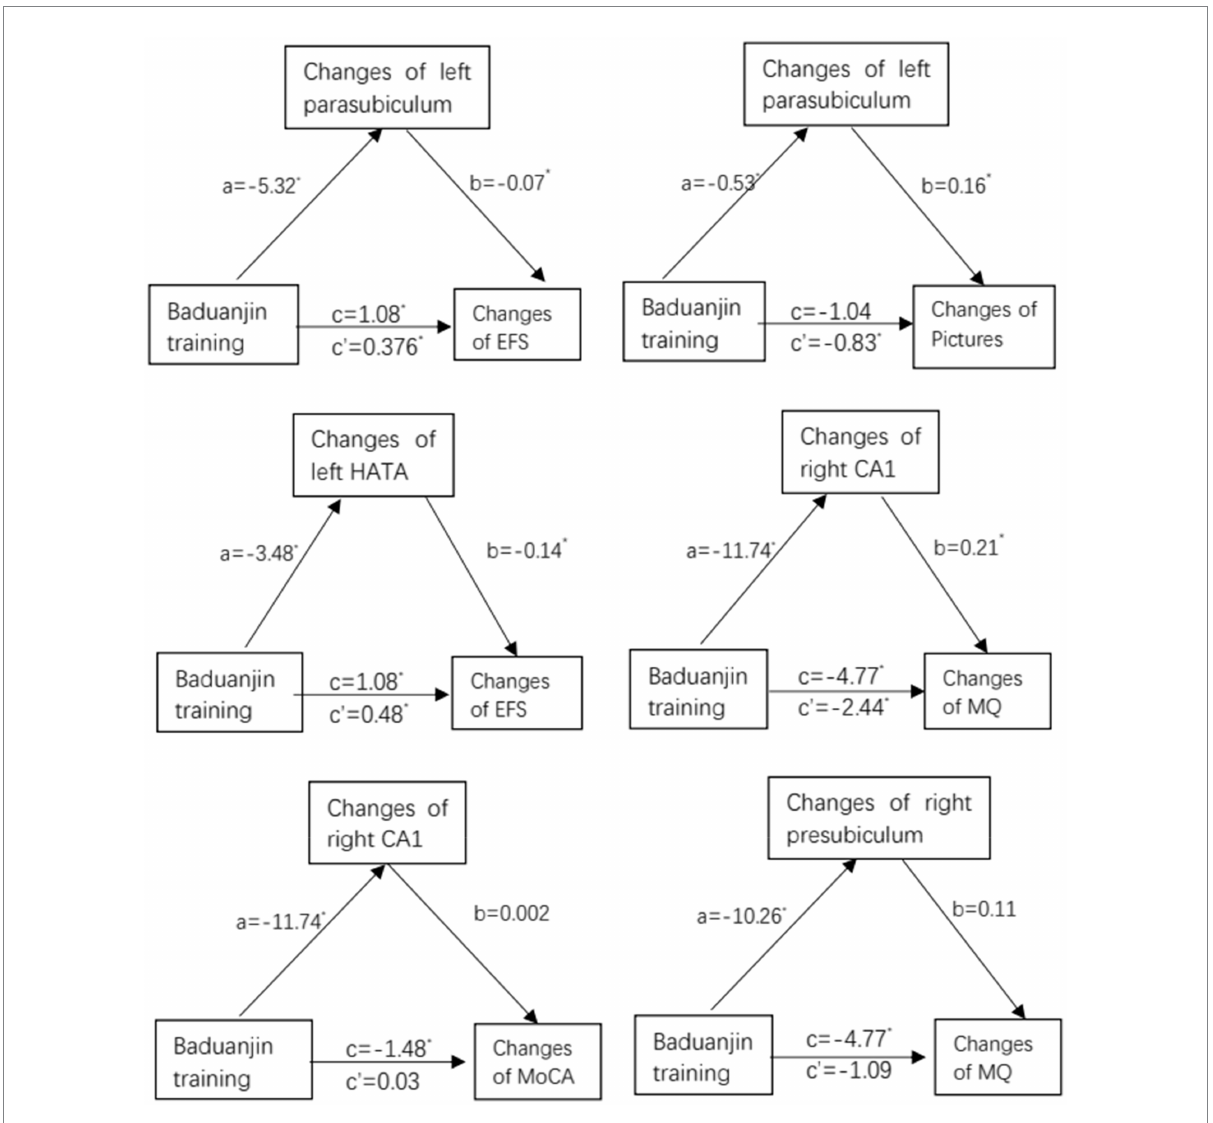
FIGURE 5 Mediation analysis: path diagram depicting mediation model 4, testing whether changes in hippocampal subregion volume (left parasubiculum, left HATA, right CA1, or right presubiculum) mediate the effect of Baduanjin training intervention vs. control (no specific exercise intervention) on improvement in cognition (MoCA, MQ, or pictures) or physical frailty (EFS). MoCA, Montreal Cognitive Assessment; MQ, Memory Quotient; EFS, Edmonton Frailty Scale; CA1, Cornu Ammonis Subfield 1; HATA, Hippocampal Amygdala Transition Area. a, b, c’ and c are unstandardized path coefficients, and * < 0.05. a-path represent effect of Baduanjin training over hippocampal subregions (left parasubiculum, left HATA, right CA1, or right presubiculum); b-path represent effect of hippocampal subregions over cognition (MoCA, MQ, or pictures) or physical frailty (EFS); c ′ -path represent indirect effect of Baduanjin training over cognition (MoCA, MQ, or pictures) or physical frailty (EFS); and c-path represent total effect of Baduanjin training over cognition (MoCA, MQ, or pictures) or physical frailty